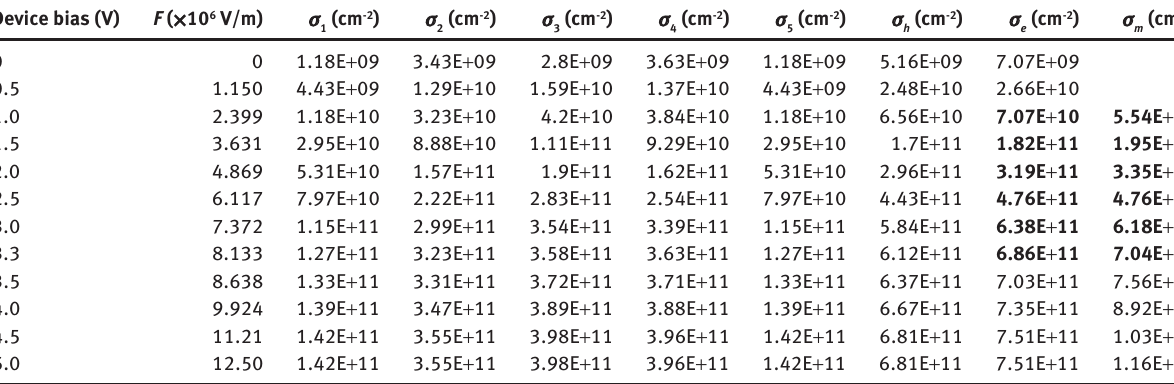
Table 4: The measured internal average electric field ( F ), the experimental charge carrier sheet density ( σ sheet density ( σ Eq. (5).